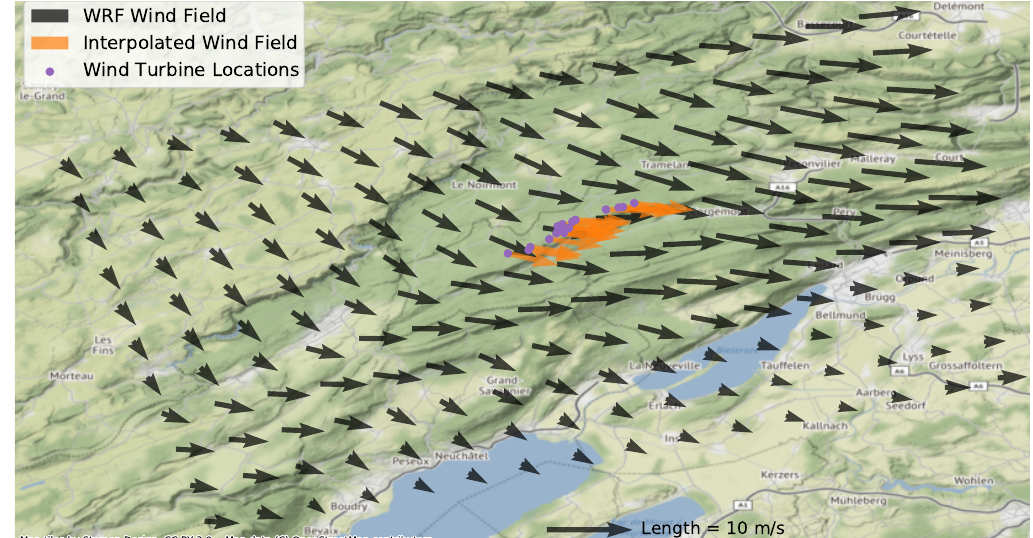
Figure 6. Wind field map. Four meteorological variables (temperature, pressure, wind speed and direction) are retrieved from WRF at each point designated by a black arrow with the scale indicated at the bottom of the figure. Those variables are then interpolated at the wind turbine locations, at four given heights: 50, 95, 150 and 200 m above ground